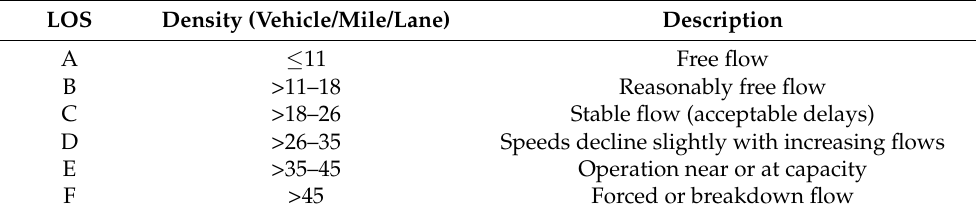
Table 4. Description of different LOS adapted from the Highway Capacity Manual (HCM)